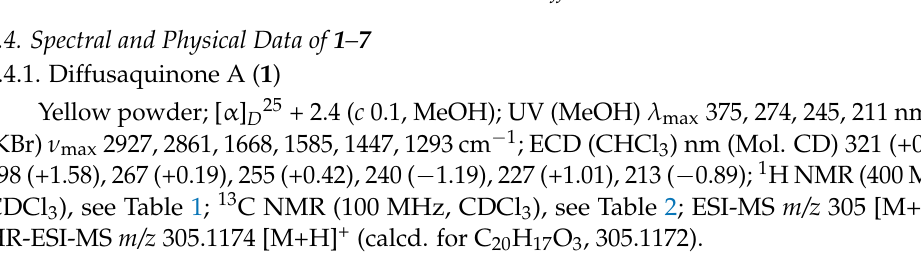
Scheme 1. The extraction and isolation flow chart of H. diffusa .